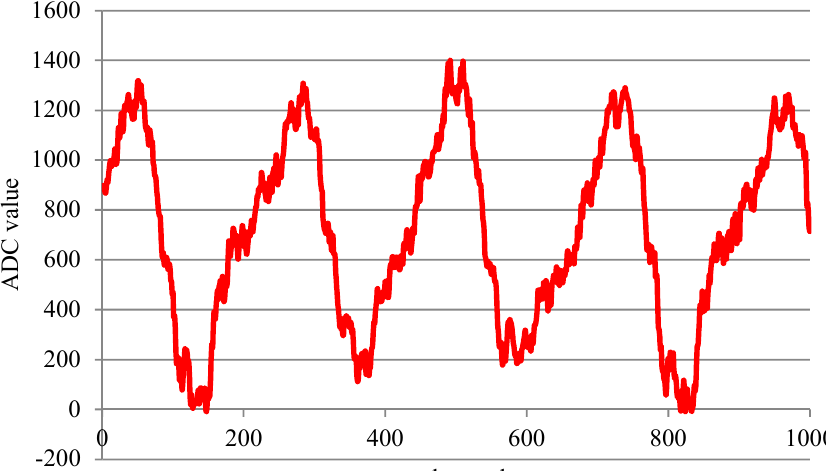
Figure 16. Signal measured by LTC1407A at 700 rpm.